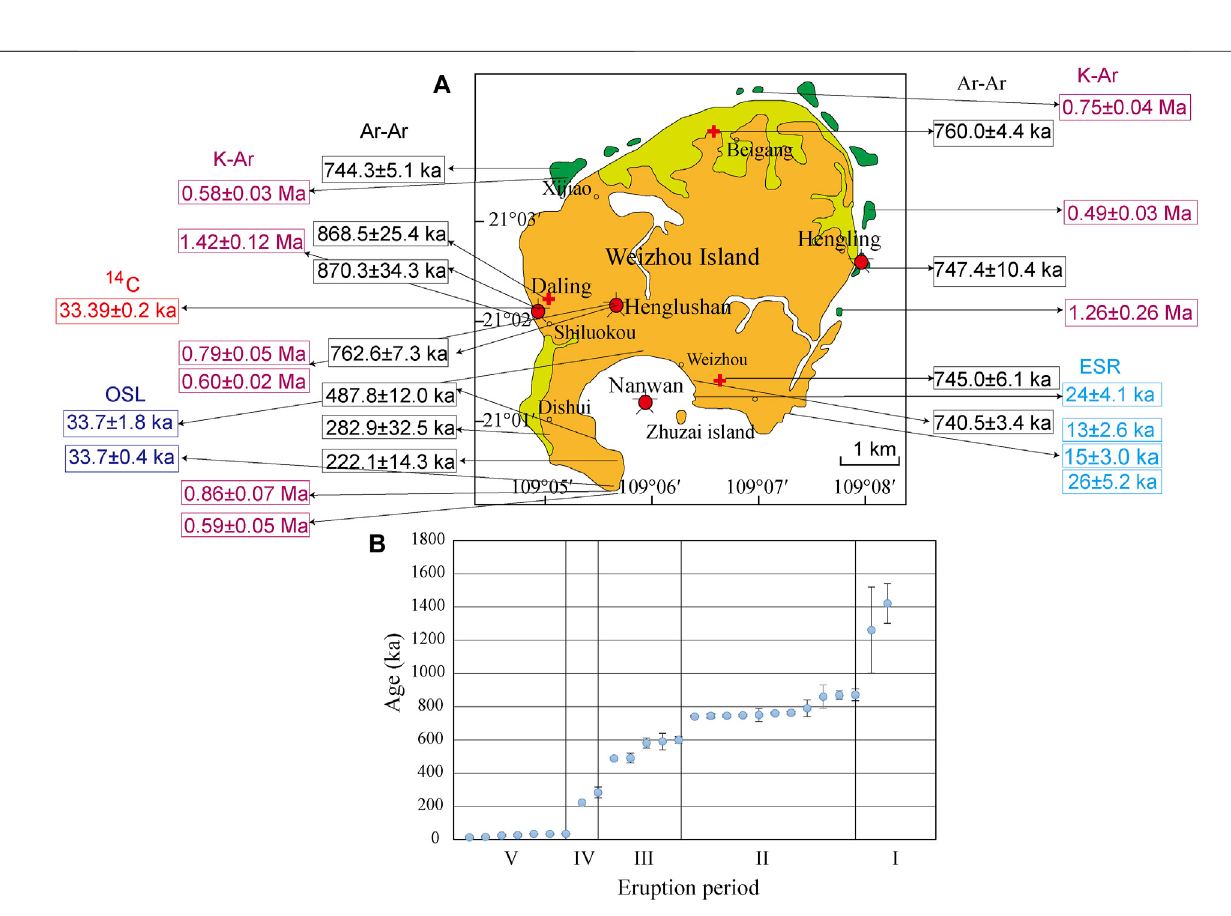
Frontiers in Earth Science |